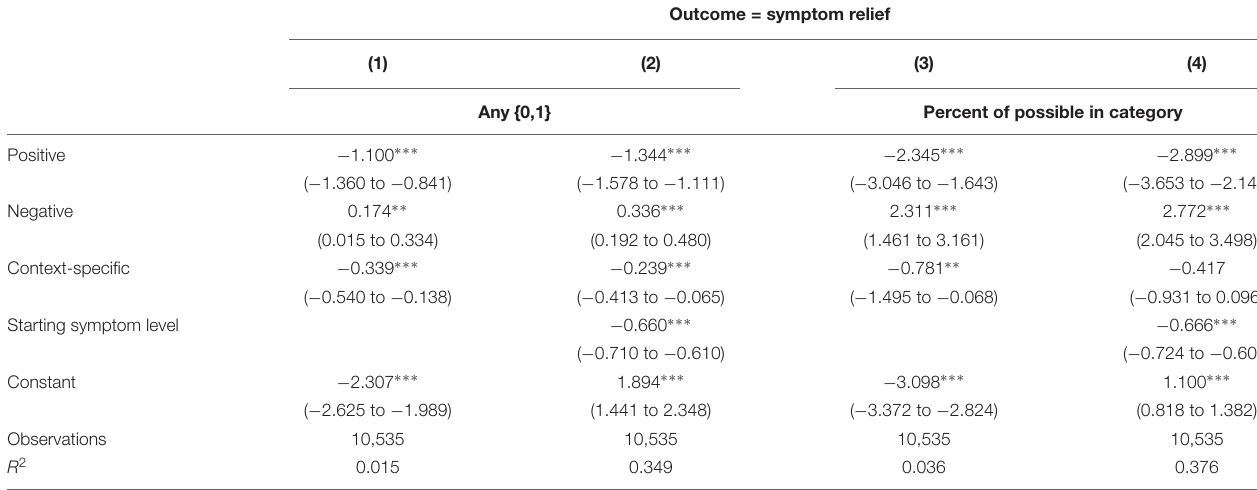
TABLE 4 | Association of positive, negative, and context-specific side effects with symptom